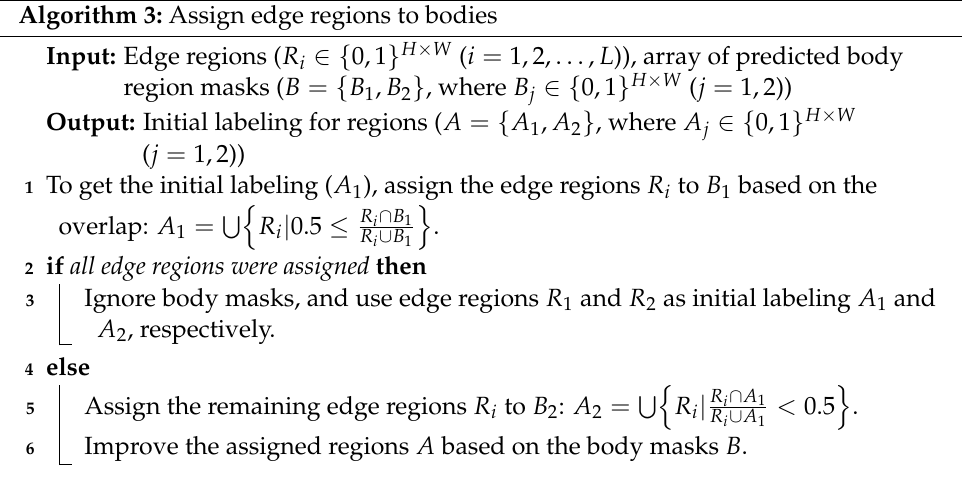
Algorithm 3: Assign edge regions to